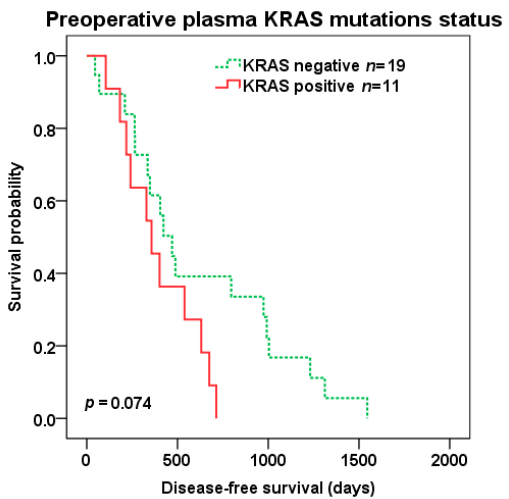
Figure 3. Disease-free survival (DFS) after liver surgery in patients with KRAS positive (red color) vs. negative (green color dotted line) pre-operative plasma samples.